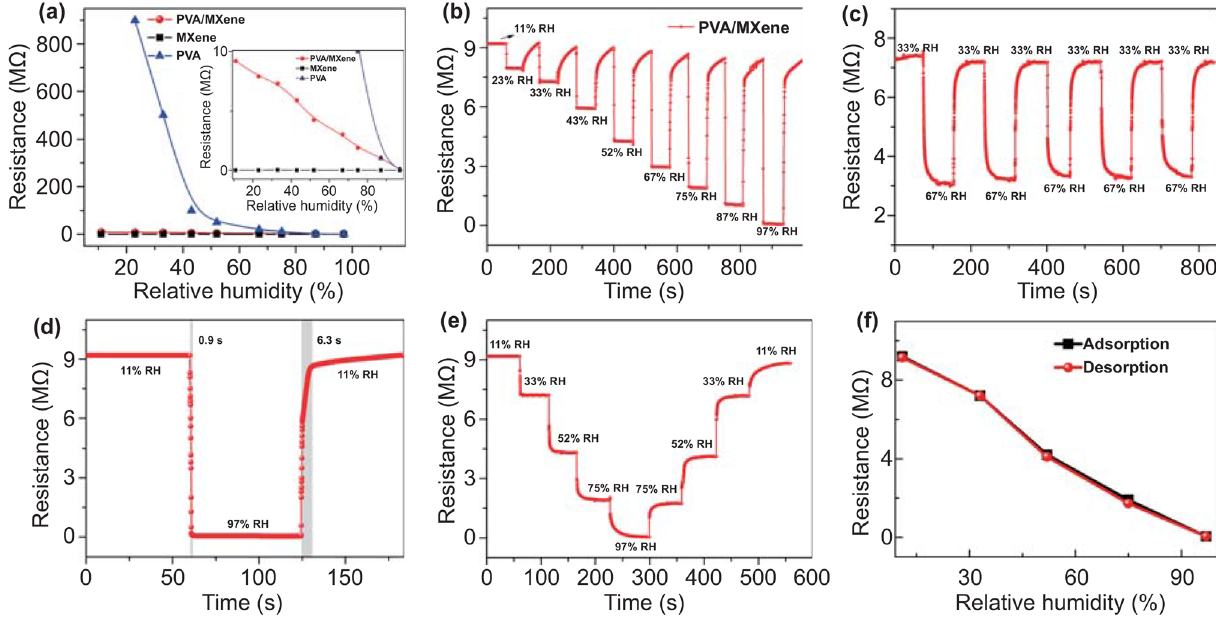
Fig. 5 a Resistance of the MXene, PVA, and PVA/MXene film sensor exposed to various relative humidities. b Dynamic resistance changes of PVA/MXene film sensor exposed to various relative humidities. c Repeatability of PVA/MXene film sensor. d Time-dependent resistance response and recovery curves of the PVA/MXene sensor between 11 and 97% RH. e Resistance of sensor with increasing and decreasing humid- ity. f Humidity hysteresis curves of the PVA/MXene nanofibers film